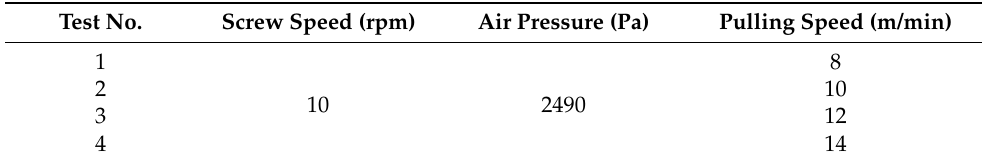
Table 3. Experimental factors for evaluation of each design model. Test